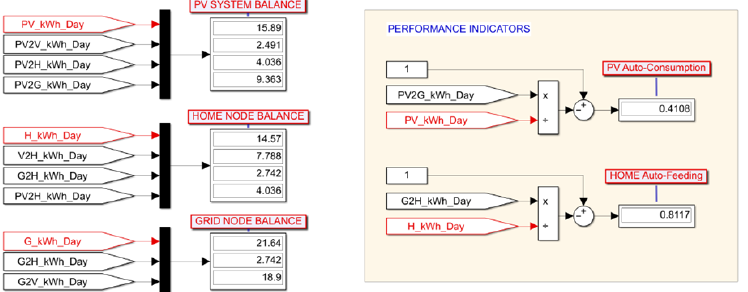
Figure 21. Energy balances at the main nodes ( left ) and performance indicators ( right ) for Case3— MW 2D.